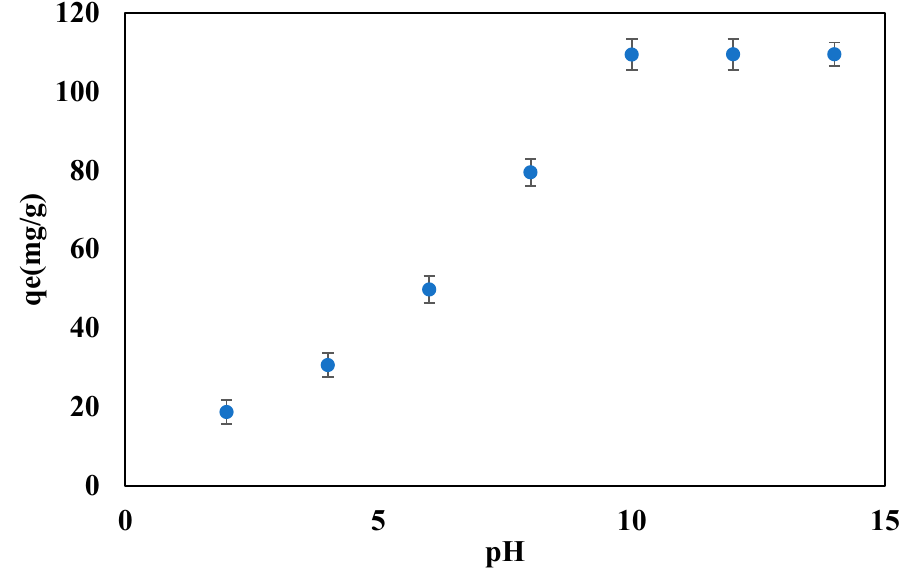
Figure 4. Effect of the pH on the adsorption capacity of the beads at 60 min contact time, 200 ppm initial oil concentration, 10 mg of beads.